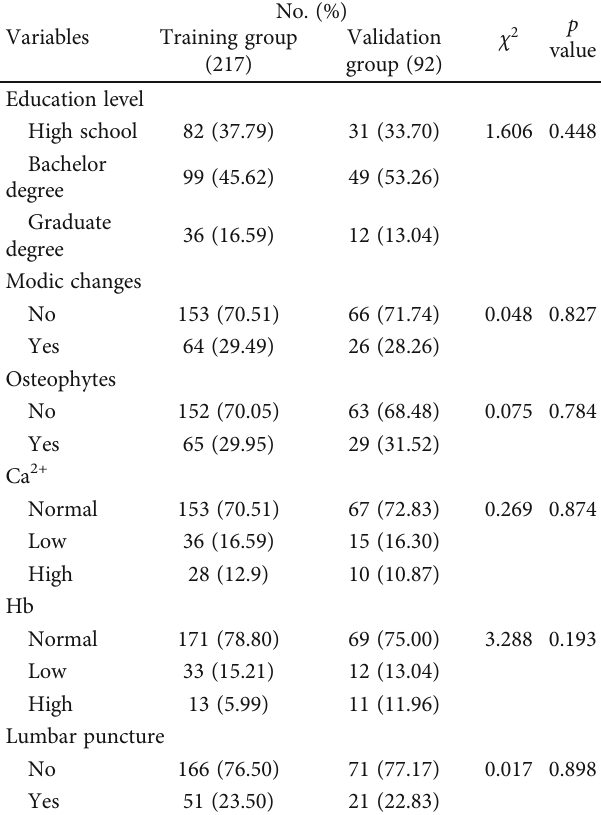
Table 1: Characteristics of participants in the training group and the validation